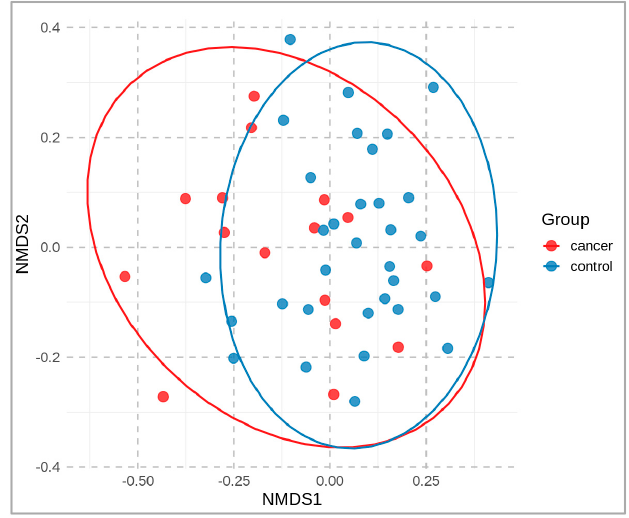
Figure 2. Two-dimensional NMDS plot of fecal microbial communities, based on beta-diversity (OTU level), derived from fecal samples of cancer patients (red) and healthy controls (blue).